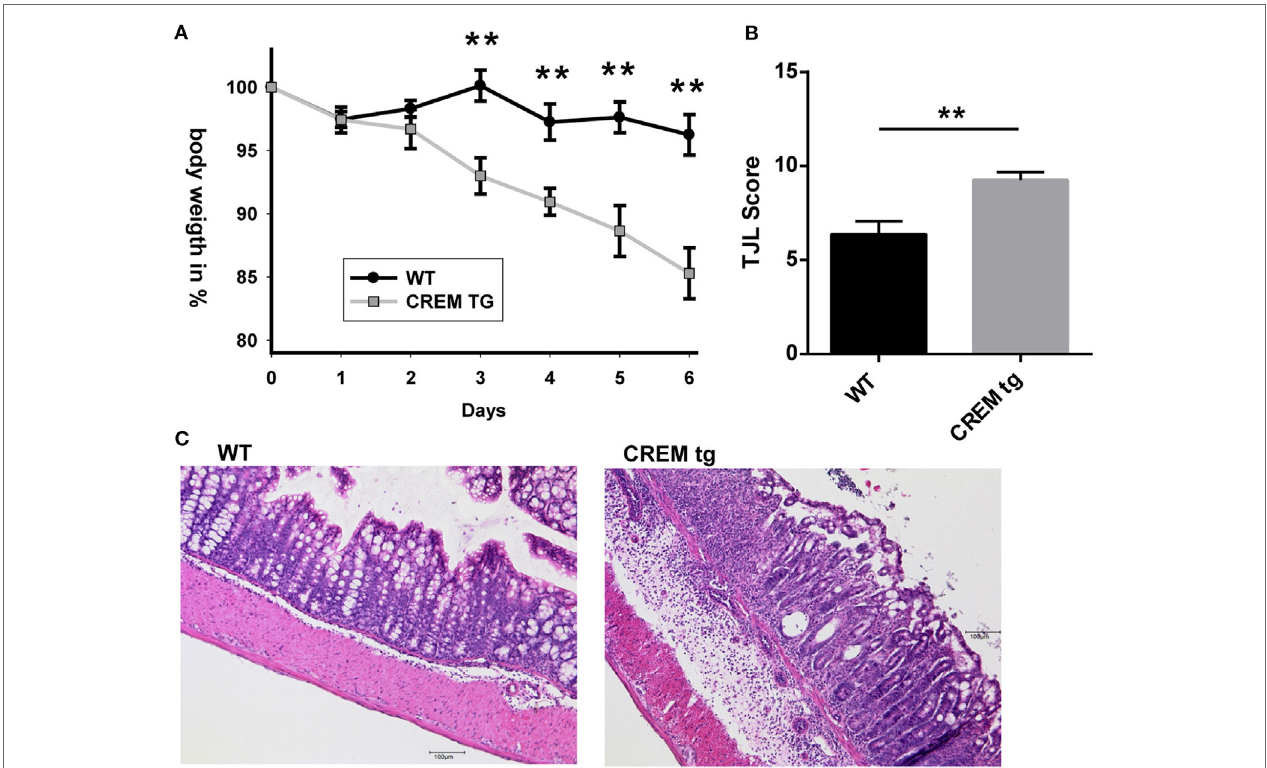
FigUre 4 | caMP-responsive element modulator alpha (creM α ) transgenic mice display enhanced disease activity in dextran sodium sulfate (Dss)-induced acute colitis . (a) Percentage of body weight loss of CD2-CREM α transgenic (tg) and wild-type (WT) mice measured daily for a period of 6 days after colitis induction with DSS ( n = 12 animals each, ** p < 0.01). (B) Results of histological scoring of colon sections from CD2-CREM α tg and WT mice on day 6 after DSS treatment ( n = 12, ** p < 0.01). (c) Representative photomicrographs of hematoxylin and eosin-stained colon sections from CD2-CREM α tg (right) and WT (left) mice at day 6 of acute DSS colitis imaged using a 10 × objective (scale bar = 100